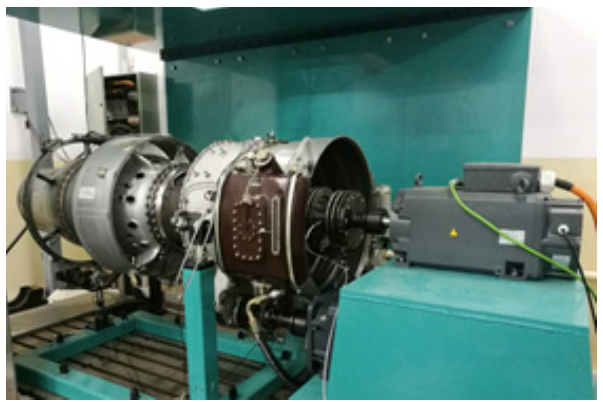
Figure 3. Aero Engine Test Bench.